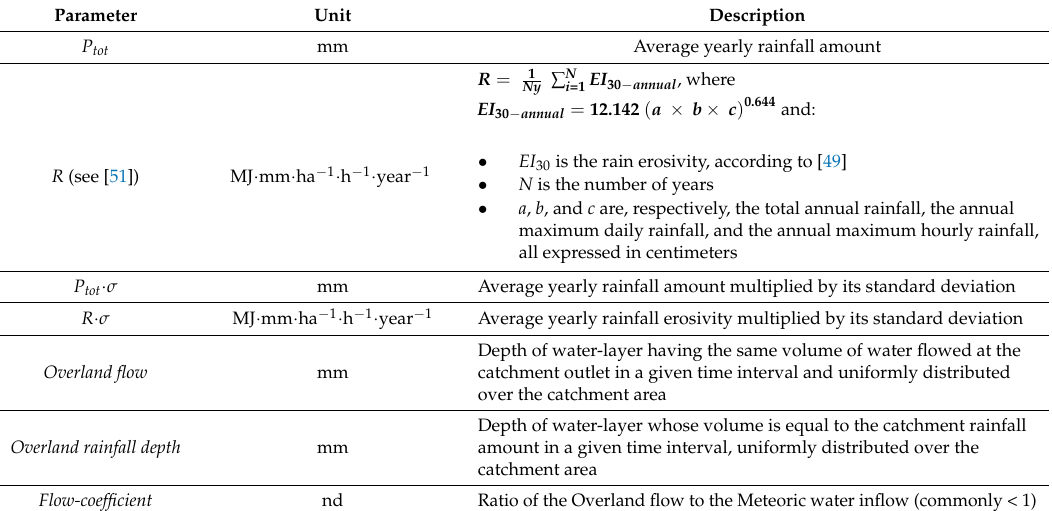
Table A7. Rainfall and overland flow